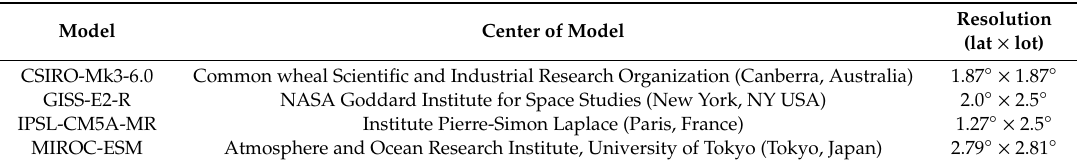
Table 1. List of the 4 global climate models (GCMs) considered for the model ensemble.